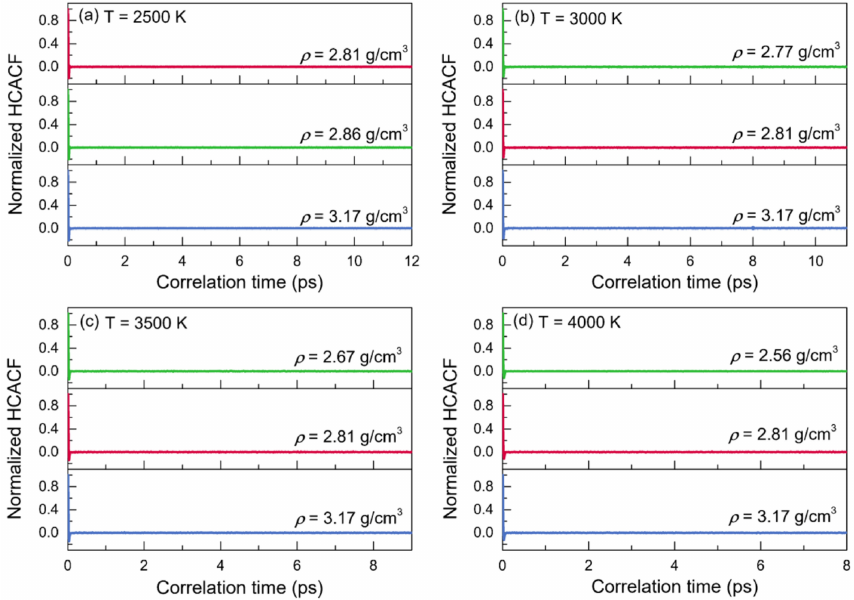
Figure 7. Normalized heat-current autocorrelations (HCACFs) for the configurations of liquid alumina with three different densities at ( a ) 2500 K, ( b ) 3000 K, ( c ) 3500 K and ( d ) 4000 K, respectively.